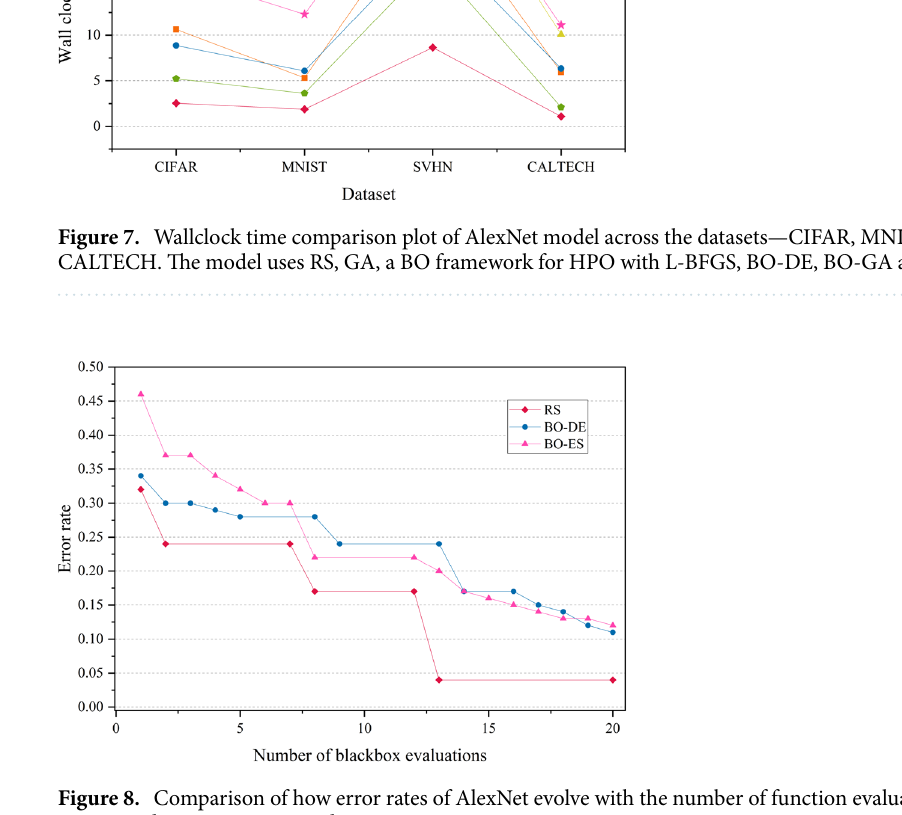
Figure 8. Comparison of how error rates of AlexNet evolve with the number of function evaluations for RS, BO-ES and BO-ES on CIFAR